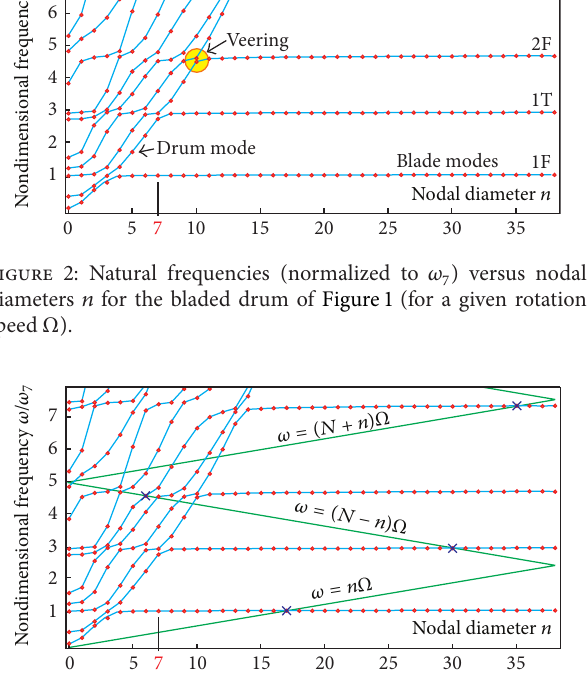
Figure 3: Resonance condition to a rotating force. Zig-zag lines superimposed on the natural frequencies versus nodal diameters plot of the bladed drum with 𝑁 = 76 blades. The resonance conditions are indicated by ×